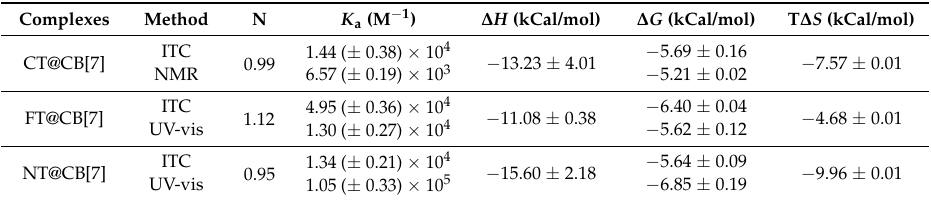
Table 1. Thermodynamic parameters of non-covalent interactions of CT@CB[7], FT@CB[7] and NT@CB[7] encapsulation complexes at 25 °C, derived from ITC, NMR and UV-vis titrations (all uncertainties are standard deviations).